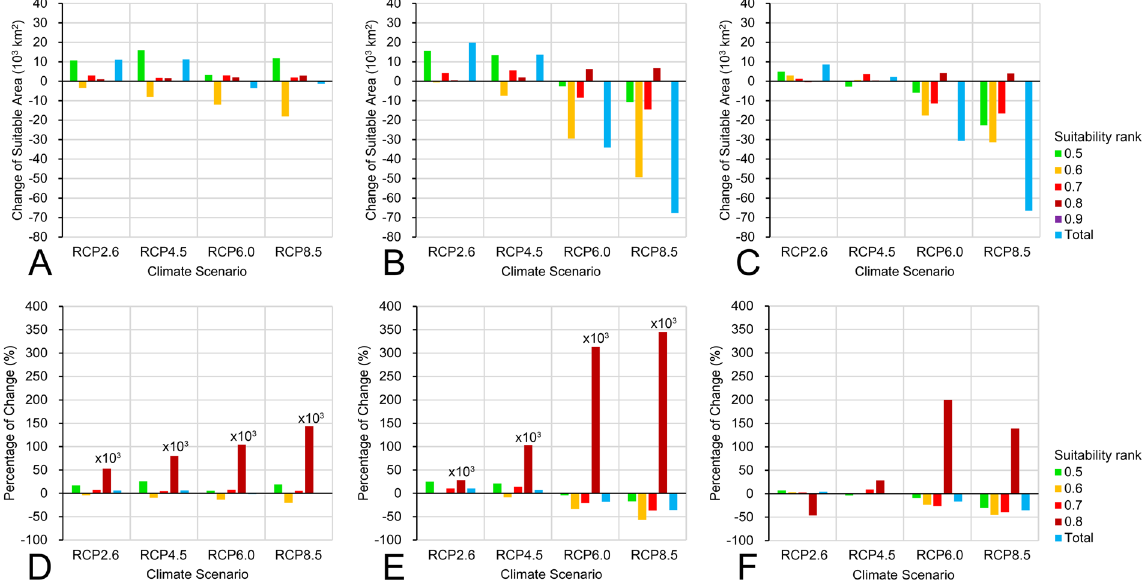
Figure 6. The change of suitable areas (10 3 km 2 ) ( A – C ) and the percentage of suitable area change (%) ( D – F ) for B. thaidina in China: ( A,D ) 2050 s vs. current, ( B,E ) 2070 s vs. current, ( C,F ) 2070 s vs. 2050